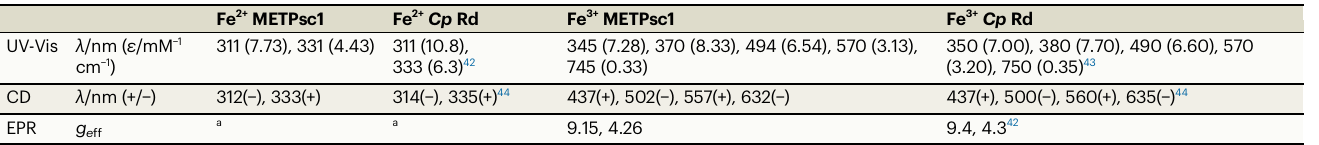
Table 1 | Spectroscopic parameters of FeMETPsc1 and Cp Rd in Fe(II) and Fe(III) oxidation states Fe 2+ METPsc1